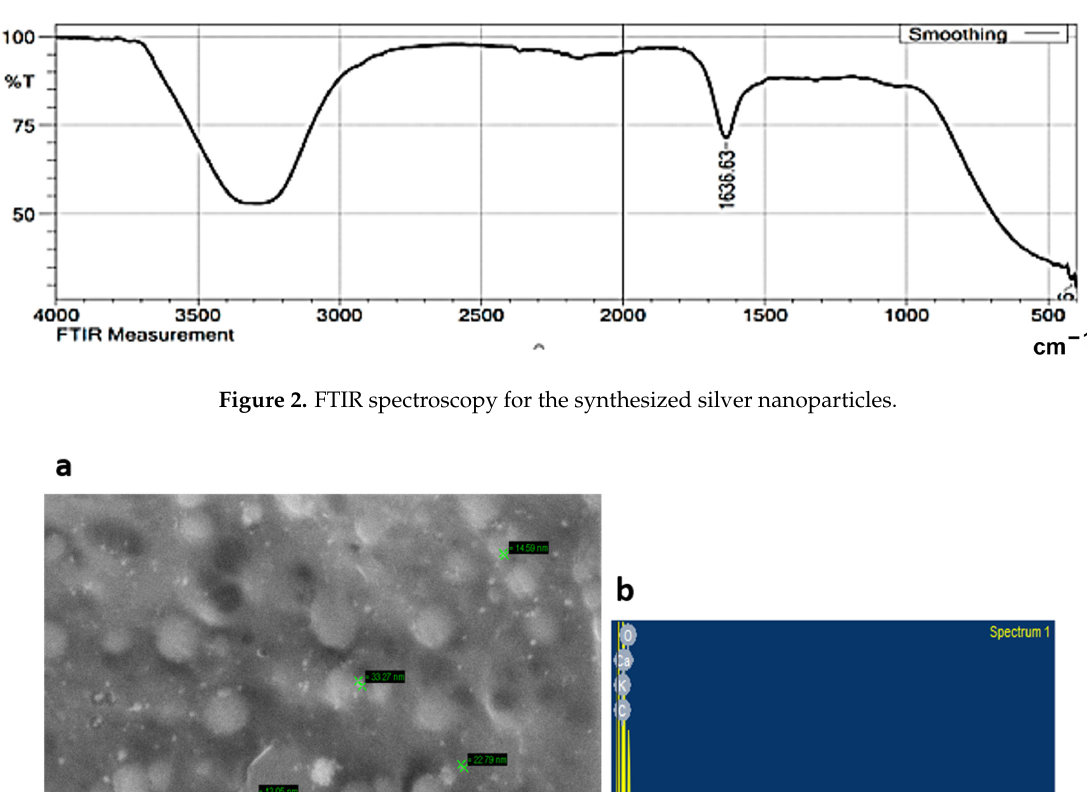
Figure 5. XRD analysis for the synthesized silver nanoparticles.